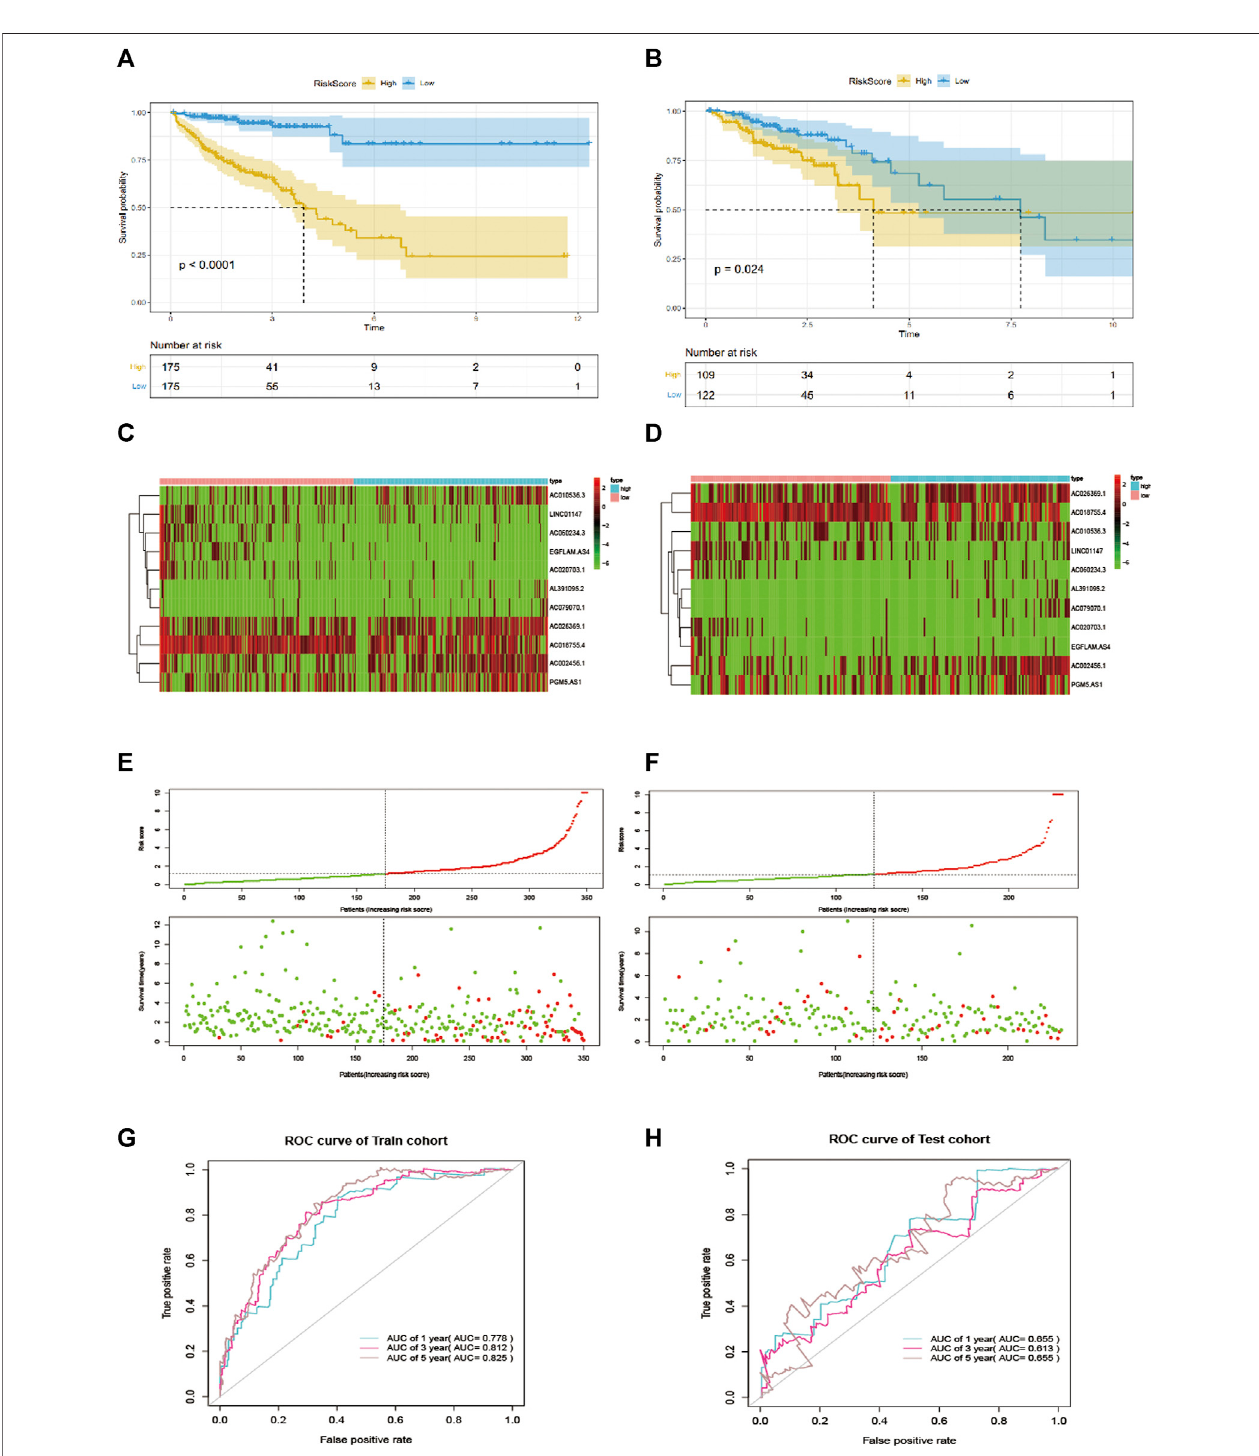
FIGURE2| EMT-related lncRNAsignature predicts OS inpatientswithCRC. (A, B) Kaplan-Meier curve toverify the predictive effectofthesignaturein thetraining andtestcohort. (C,D) Theheatmapoftheexpressionpro fi lesofmembersinthe11-lncRNAsignature. (E,F) .Distributionofriskscoresperpatientinthetrainingandtest cohort. (H, G) : ROC curve analysis to evaluate the diagnostic ef fi cacy of the signature.